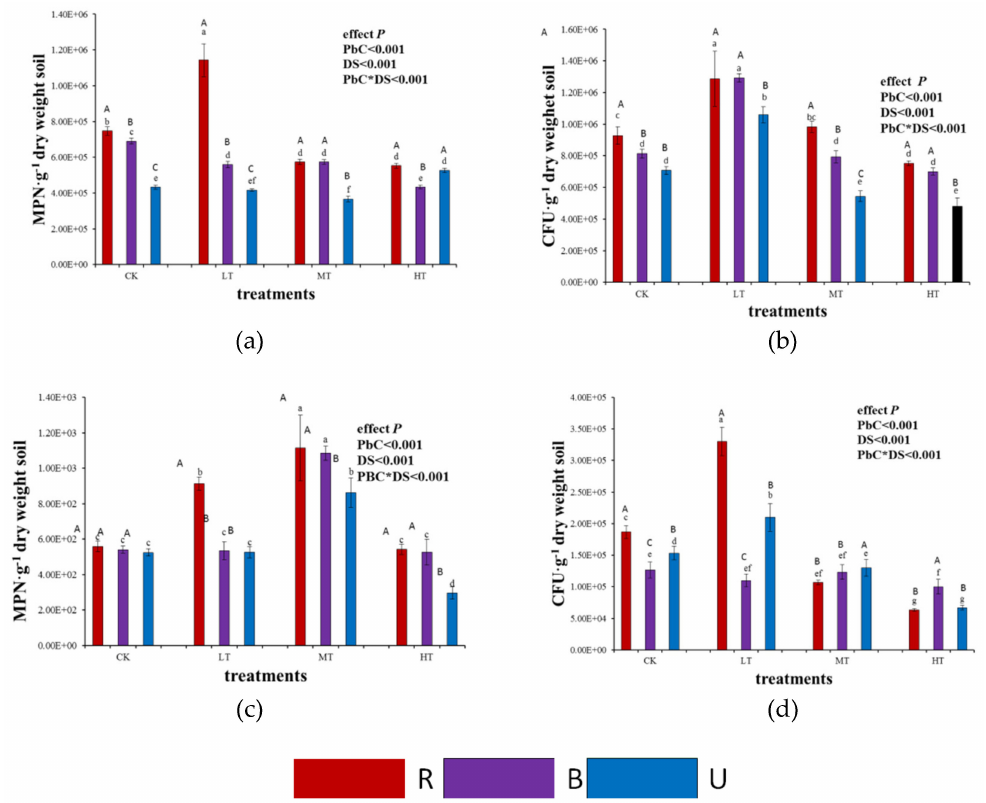
Figure 3. The quantities of ammonifying bacteria ( a ), inorganic phosphorus-solubilizing bacteria ( b ), nitrosobacteria bacteria ( c ), and nitrogen-fixing bacteria ( d ) in different Pb levels. CK, 0 mg/kg; LT, 500 mg/kg; MT, 1000 mg/kg; HT, 1500 mg/kg; R, rhizospheric soil; B, bulk soil; U, unplanted soil. PbC, Pb concentration effect; DS, different sources of soil; PbC × DS, the interactive effect of Pb concentration and different sources of soil. Different letters indicate that values differ significantly at p < 0.05. The lowercase letters represent the global comparison and uppercase letters represent the intra-soil type comparisons. Values represent mean ± SD ( n =